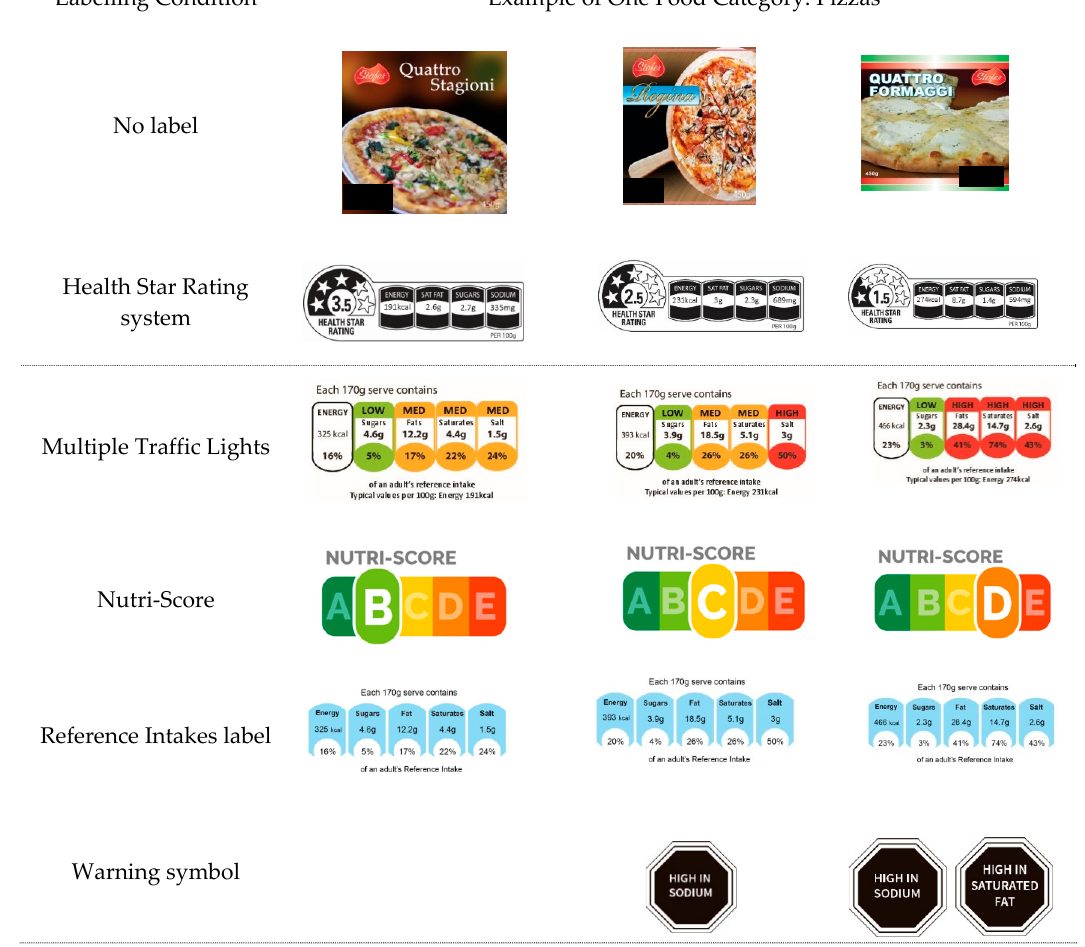
Figure 1. Example of the set of pizzas used for ranking tasks in the present study, with the associated FoPLs. The black rectangle at the bottom corner of the figure corresponds to the placement of the label.